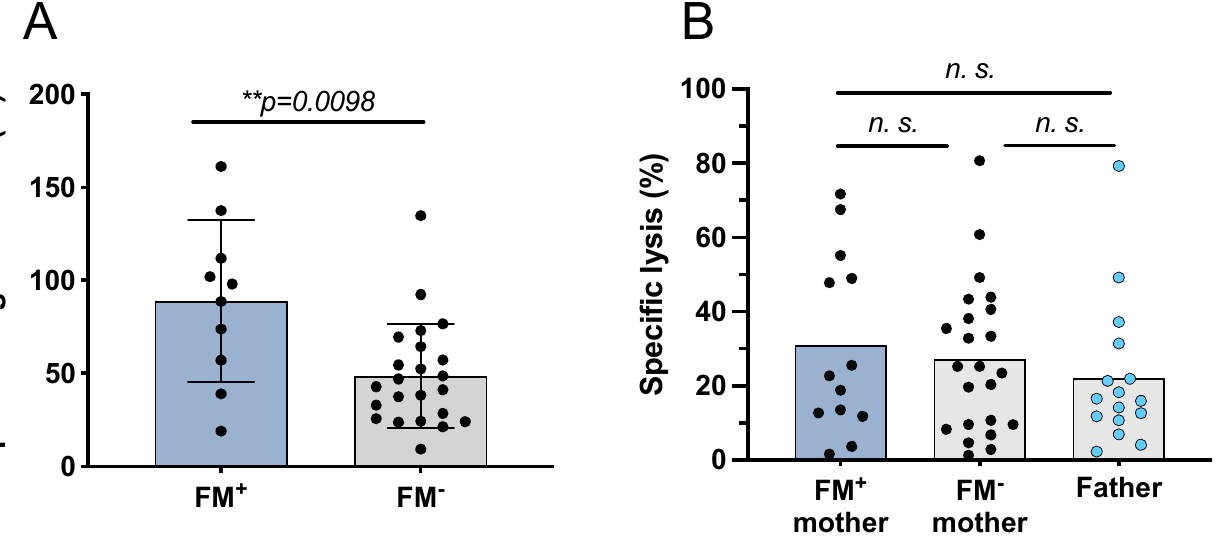
Figure 5. Specific degranulation and lysis of activated NK cells of FM + and FM − mothers after co-culture with leukemic blasts or K562. ( A ) Maternal NK cells were isolated and IL-2/IL-15 pre-activated overnight. The next day, cells were co-cultured with filial leukemic blasts or K562 in an effector to target cell ratio (E:T) of 1:10, for four hours. Mothers were grouped into FM + and FM − . Specific degranulation of NK cells against filial blasts was calculated considering degranulation against K562 as maximum degranulation. ( B ) Analysis of maternal and paternal NK cell killing of leukemic blasts (E:T 10:1). Influence of a persisting FM (FM + ) in mothers on NK cell cytotoxicity against filial blasts compared to fathers. Statistical analysis was performed using Wilcoxon test for paired samples and Mann–Whitney test for unpaired samples. Significance level ** p < 0.01, n. s. not significant.